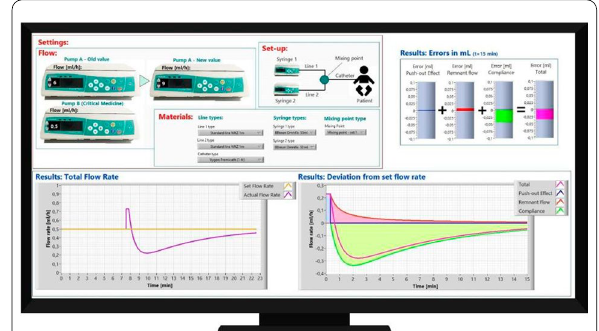
Figure 1 Impression of the predictive tool. In the top-left the two- pump system is described. The set flowrate of pump A is changed. In ‘Materials’ the syringes and mixing points that are used can be selected from the drop-down menus. The impact of changing the set flowrate on pump A on the resulting flow of the substance in pump B at the vascular access point is presented in the different figures. In the top-right the total dosing errors is shown. The bottom-left figure shows the set flowrate (yellow) and the actual flowrate (purple) of the substance in pump B. The bottom-right figure shows the contribu- tion of different factors to the